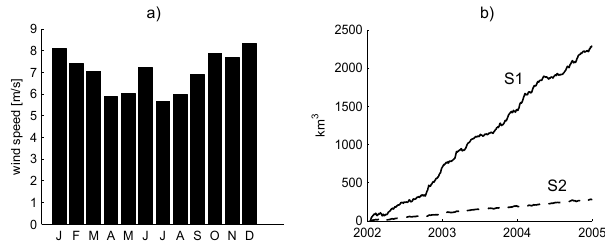
Fig. 6. Simulated mean oxygen concentration for the bottom wa- ter (below 15m depth) in the oxygen model domain (Arkona basin excluded). The black line indicates the reference simulation, green line Simulation 1 with constant respiration rates and red line Simu- lation 2 with constant oxygen saturation at the surface.